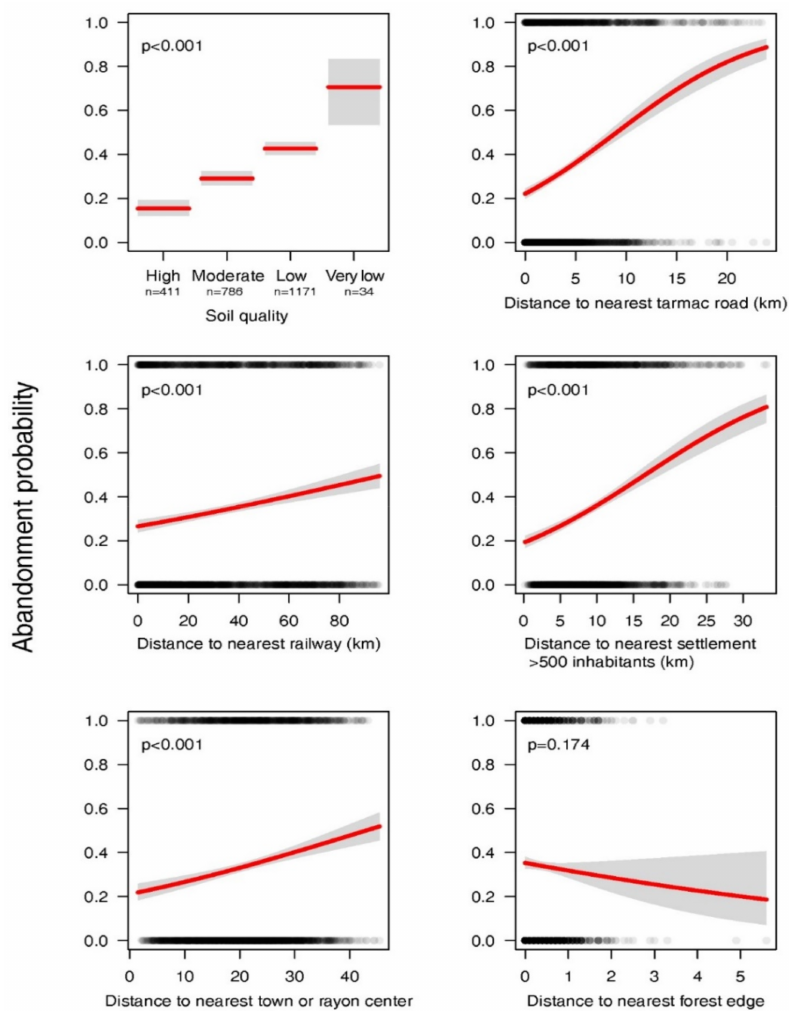
Figure 2. Predictions of cropland abandonment probability from univariate logistic regression models. p -values indicate significant associations between abandonment probability and the respective variable. Models are plotted with standard errors (grey intervals). The data is overplotted (0—samples of stable cropland, 1—samples of abandoned